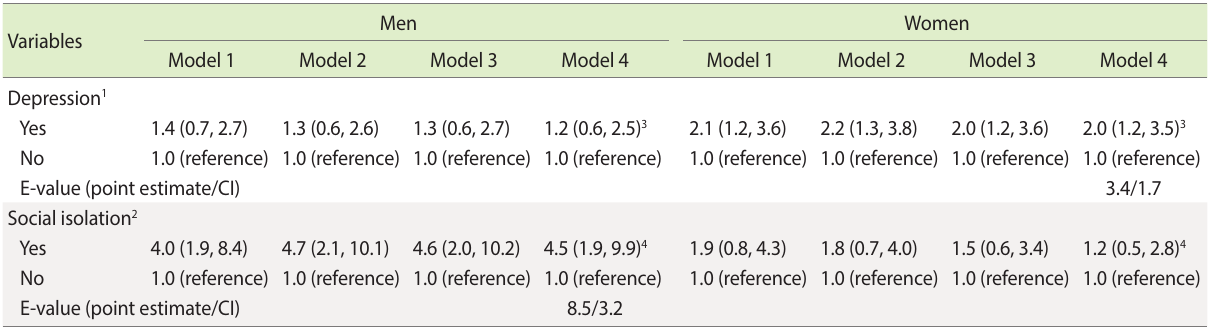
Table 3. Relative risk of depression and social isolation for 2-year mortality in men and women